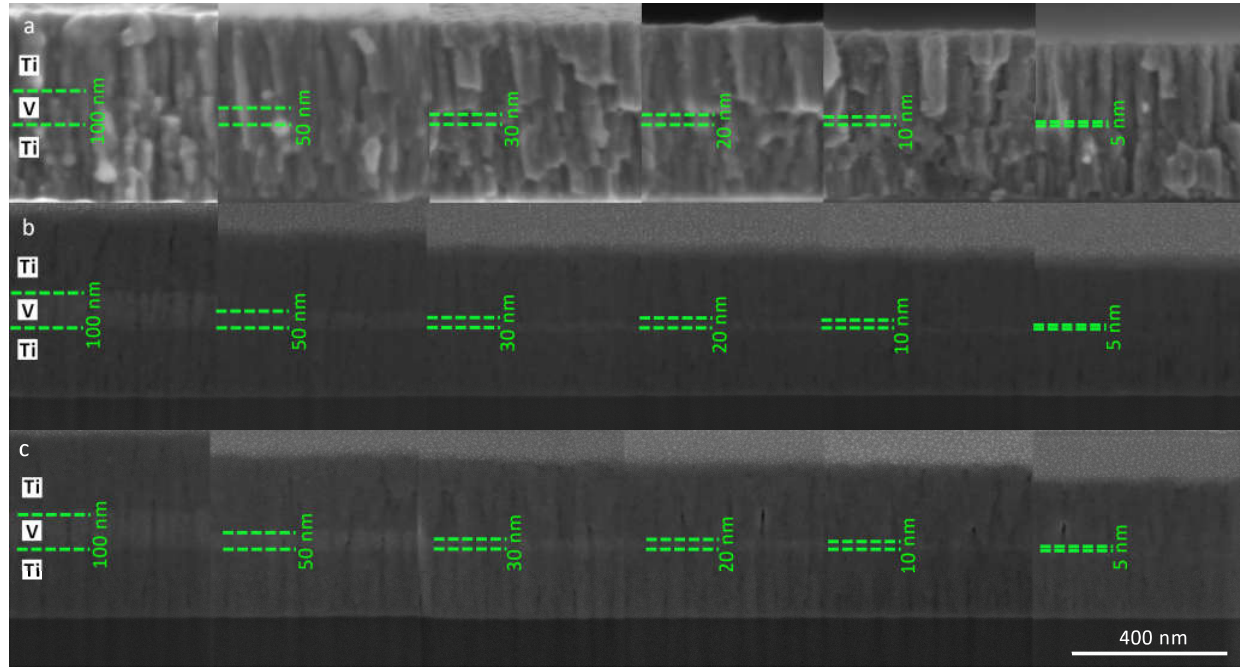
Figure 4. Comparison of the resolution afforded by the preparation of Ti/V/Ti multilayer cross sections by: ( a ) fracturing, ( b ) FIB/Ga, ( c ) PFIB/Xe, where the thickness of the middle V layer was reduced from 100 nm to 5 nm. Note: SEM images were recorded in high resolution, and their original version can be found in Supplementary